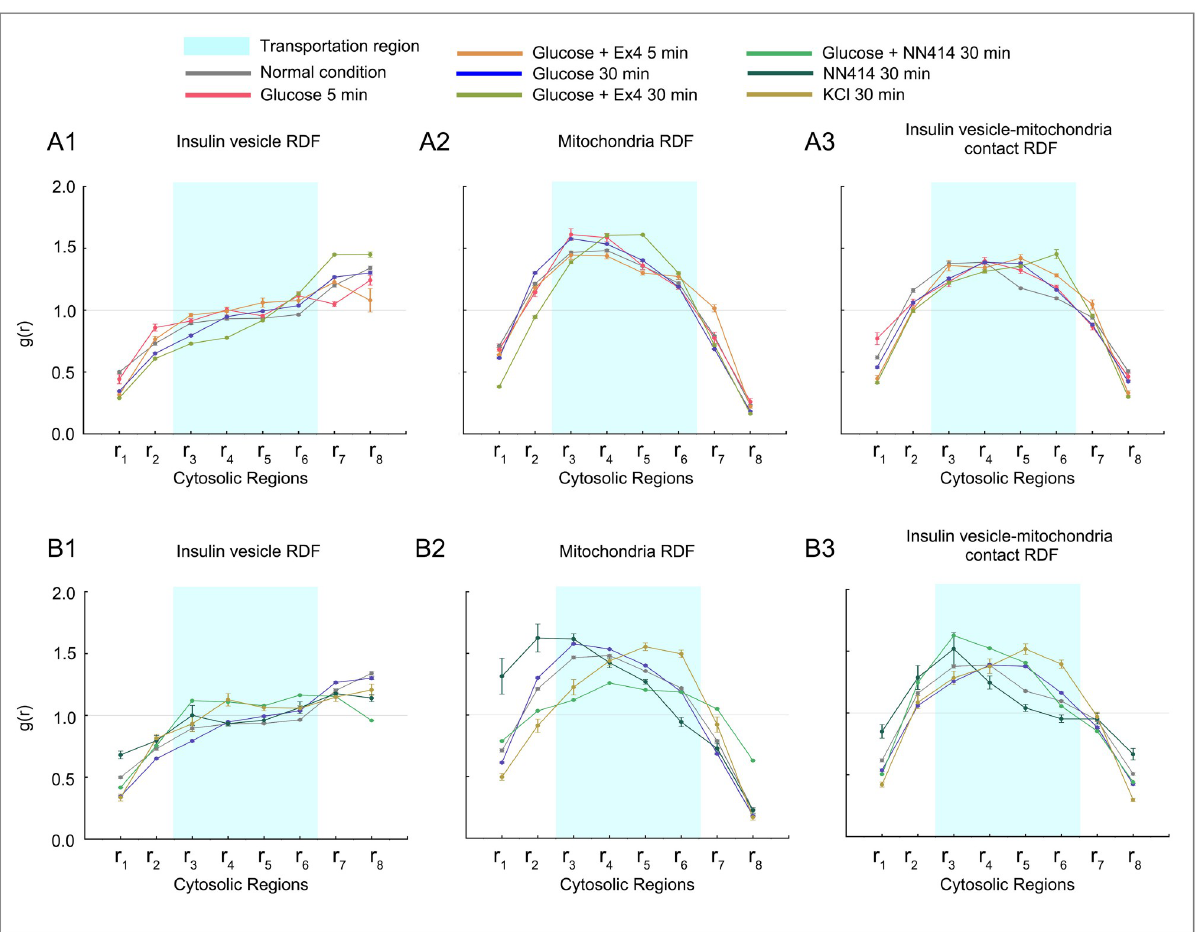
Fig 4. Radial distribution function (RDF) of insulin vesicle, mitochondria, and insulin vesicle-mitochondria contact under the various treatment conditions. (A1-A3) RDF distributions under glucose and Ex-4 treatment conditions compared to glucose treatment/normal condition. (B1-B3) RDF distributions under glucose and NN414 treatment conditions compared to glucose treatment/NN414 treatment/KCl treatment. Standard deviations are marked at each point to represent bias for datasets in the same condition.